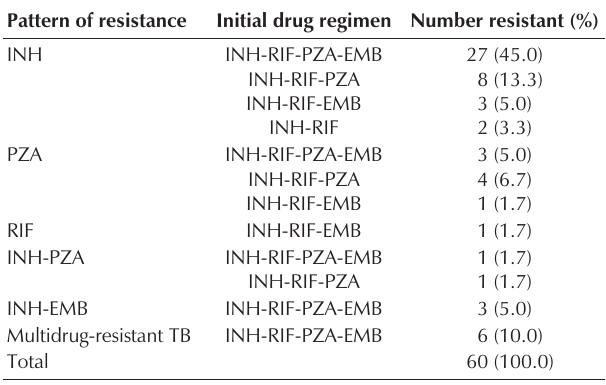
Initial drug regimen according to pattern of resistance for tuberculosis cases in Montreal from 1995 to 1998 Pattern of resistance